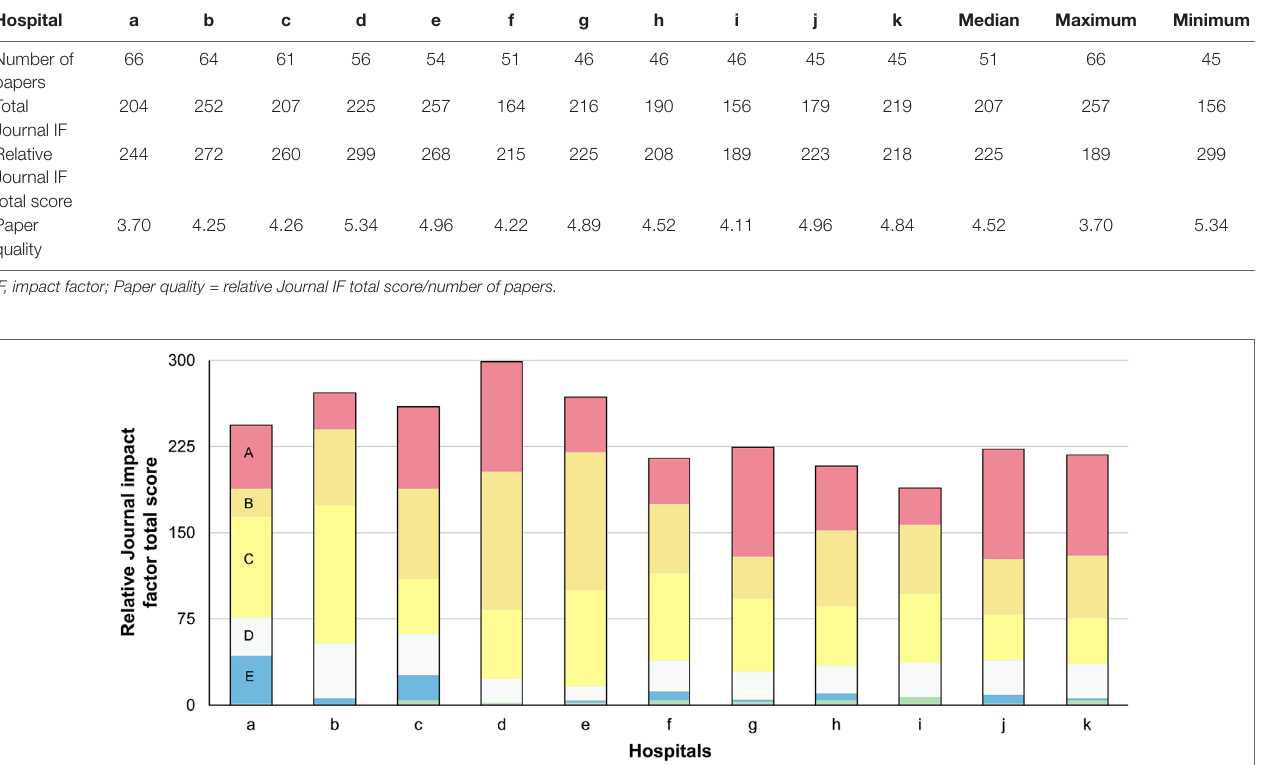
FIGURE 1 | Distribution of journal rank by medical